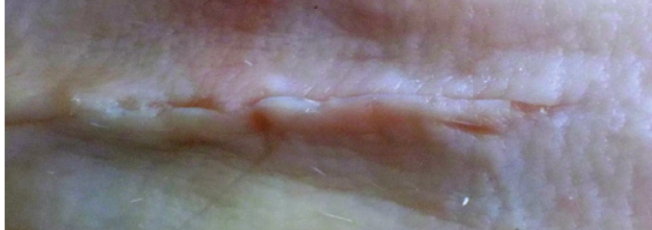
FIGURE 3 - Skin suture with hidden points in X.